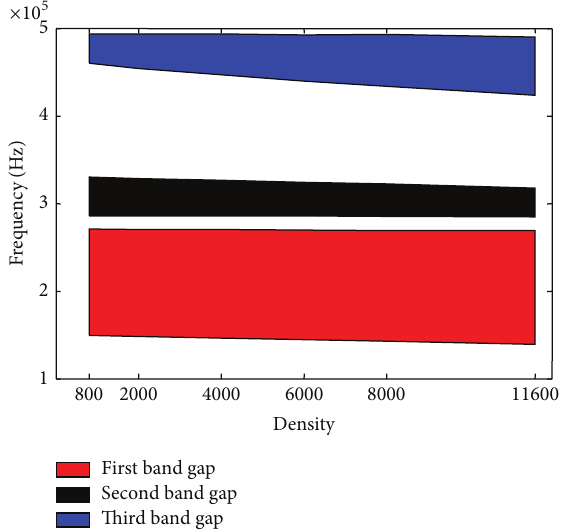
Figure 8: The evolution of the band gap as a function of the density of the connection